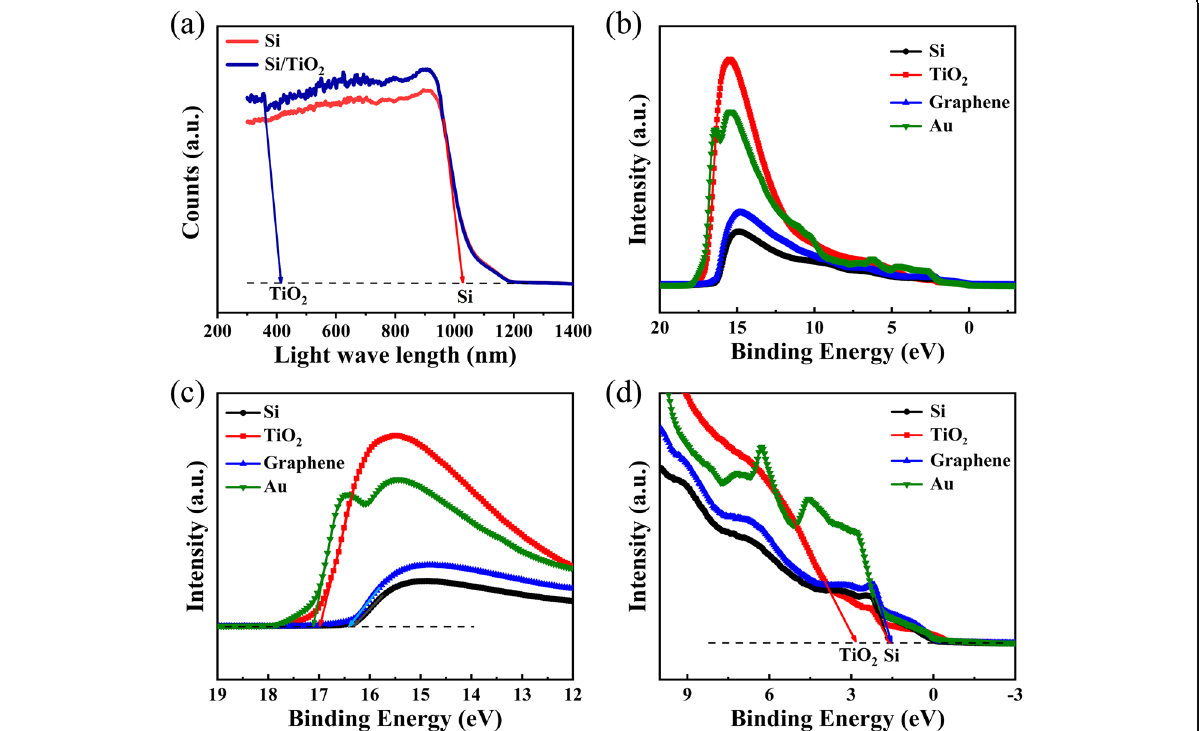
Fig. 3 Absorption spectra and UPS spectra. a The absorption spectra of Si and TiO 2 /Si. b UPS spectra of Si, TiO 2 , graphene, and Au. c Enlarged parts of b showing the secondary electron onset. d Enlarged parts of b showing the valence band